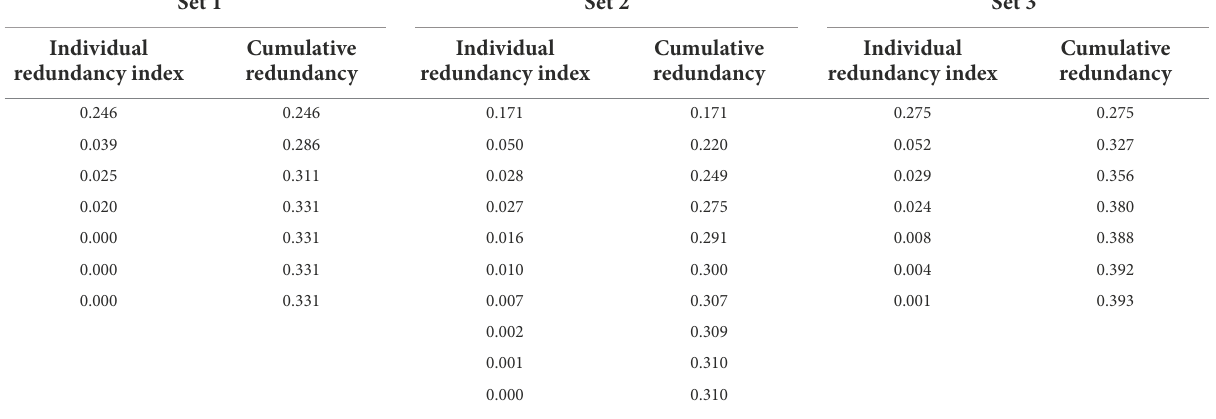
TABLE 4 Individual and cumulative redundancy